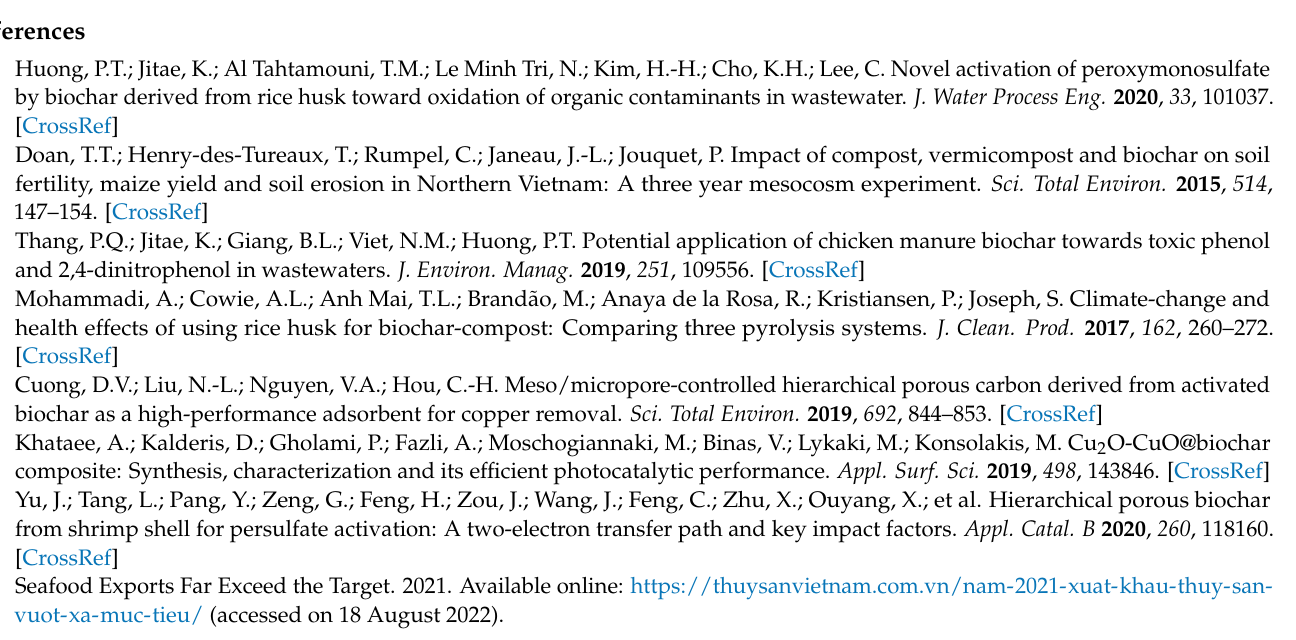
catalysts; Figure S2: SEM image of Ru/C-KOH-1 catalyst; Figure S3: SEM image of Ru/C-KOH-2 catalyst; Table S1: List of chemicals/reagents used in this